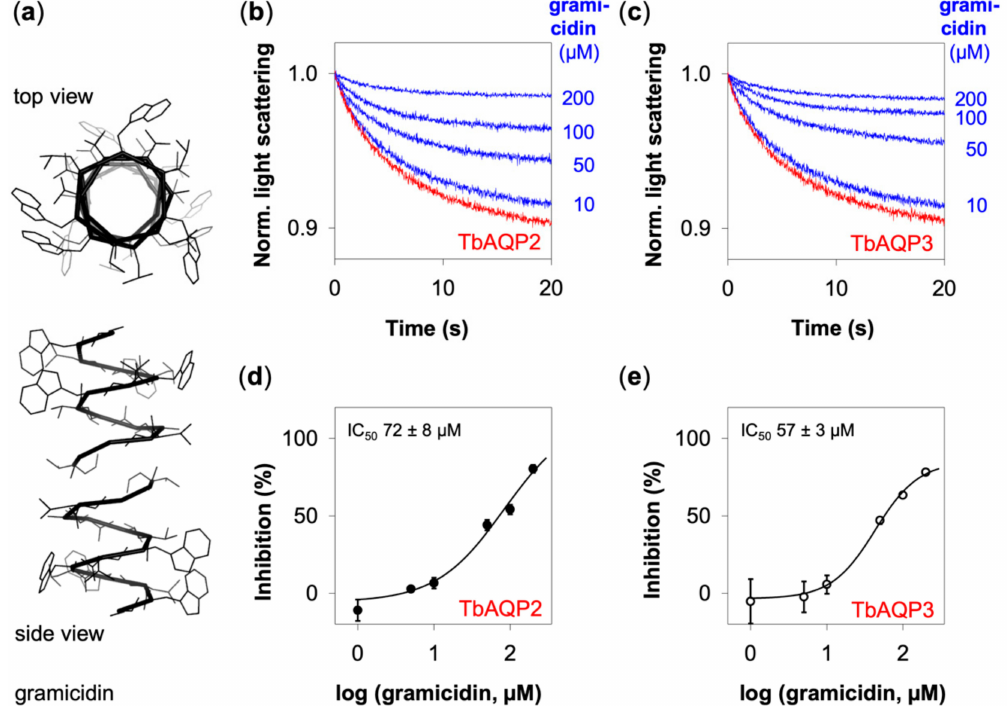
Figure 5. Inhibition of TbAQP2 and TbAQP3 by gramicidin. ( a ) Depictions of the gramicidin transmembrane ion channel (PDB #1mag) in a top down and side view. ( b ) Shown are normalized light scattering signals of TbAQP2 glycerol permeability without (red trace) and with gramicidin (blue traces). ( c ) Normalized light scattering curves of TbAQP3 without (red trace) and with gramicidin (blue traces). The curves in ( b , c ) were averaged from 8–9 traces and normalized. ( d ) IC 50 curve of TbAQP2 inhibition by gramicidin. ( e ) IC 50 curve of TbAQP3 inhibition by gramicidin. Shown are mean values ± SEM ( n = 2–3). The ethanol content was kept at a final concentration of 1%, except for 200 µ M gramicidin for which an ethanol concentration of 2% was